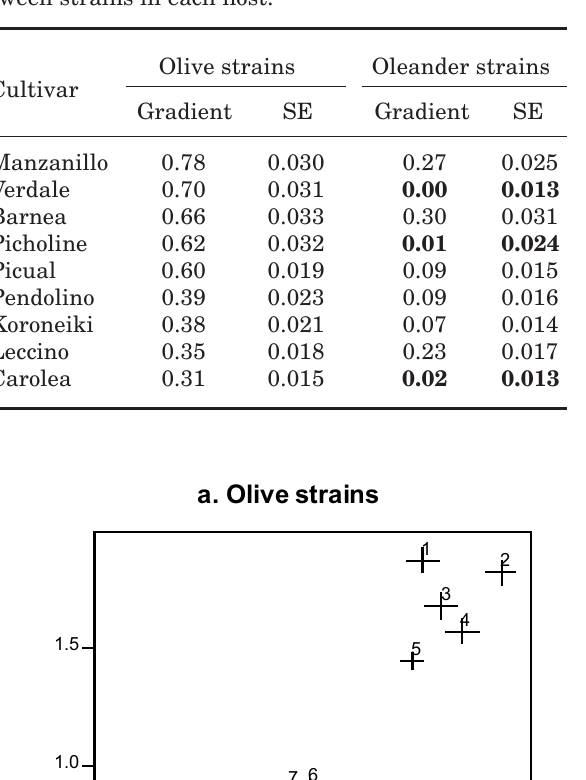
Table 4. Gradients of combined data representing reac- tions of nine olive cultivars inoculated with P. savasta- noi olive knot strains ICMP 13519 and 13813 and ole- ander knot strains ICMP 791 and 13815 recorded after 2 months. Values are expressed as change in gall diam- eter / ten-fold change in inoculum concentration. Mean gradients with their standard errors are indicated. Val- ues in bold indicate significantly different reactions be- tween strains in each host.